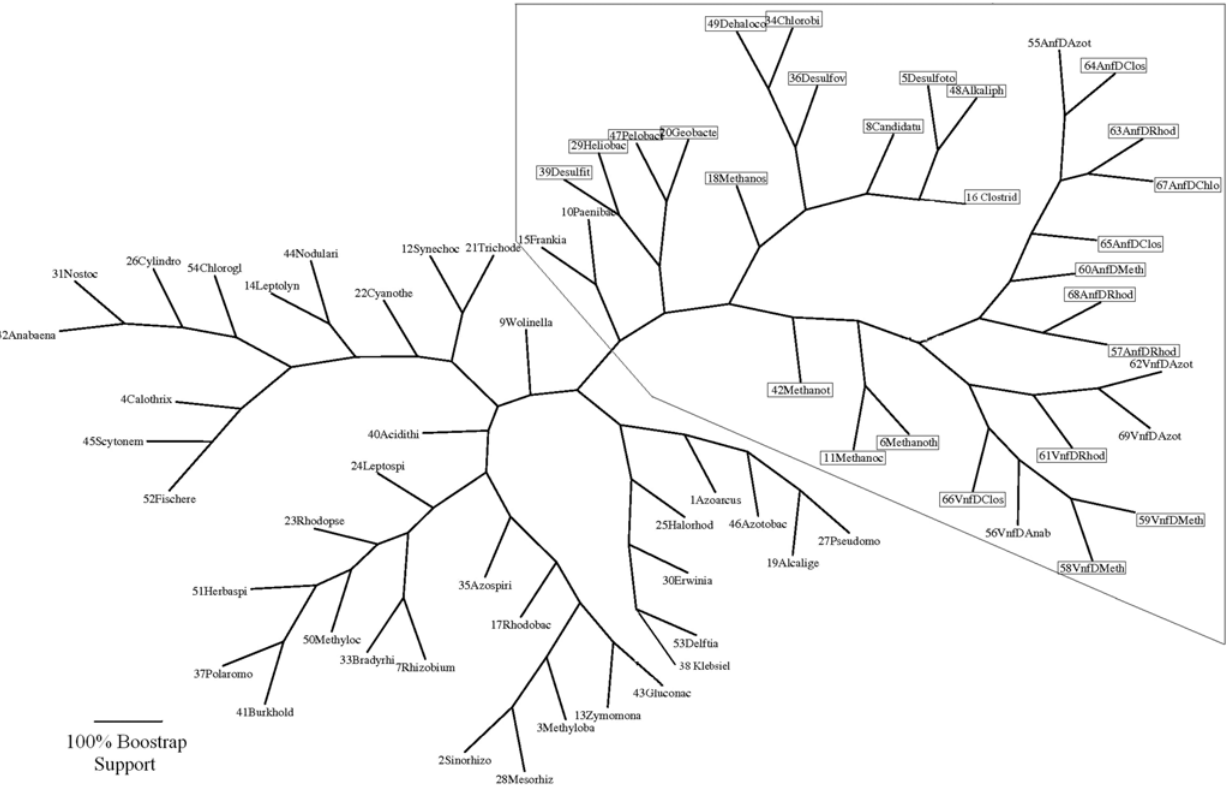
Figure 2. Phylogeny of nitrogenases. The phylogeny is constructed based on the sequences and alignment in Figure S1. See the legend in Table S4 for leaf labels, which have been truncated to 10 letters. The outlined region is summarized in Figure 3. The branch lengths indicate the percentage of bootstrap samples that support the branching pattern. Strict anaerobes are outlined in boxes.